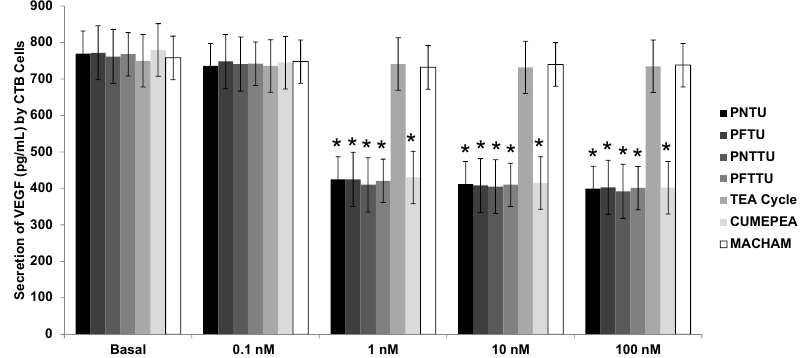
Figure 3. Cytotrophoblast (CTB) cells were treated with different concentrations of synthetic receptors (SRs), and the levels of Vascular Endothelial Growth Factor (VEGF) were measured in the cell culture media by Enzyme-Linked Immunosorbent Assay (ELISA). The SRs significantly (* p < 0.05) downregulated the secretion of VEGF by CTB cells. The results are presented as the mean ± Standard Error Mean (SEM) (n = 6, 4 replicates each).